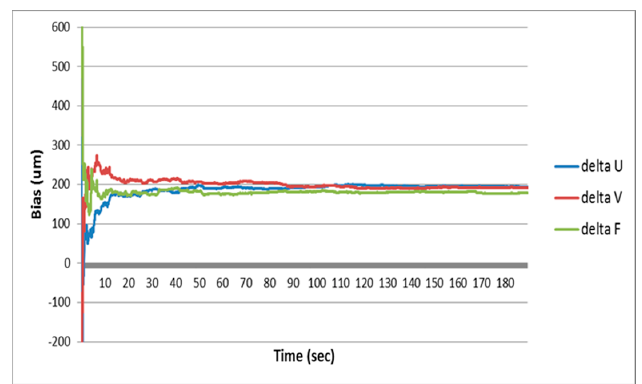
Figure 5. Camera sensor error estimation results of the simulation.